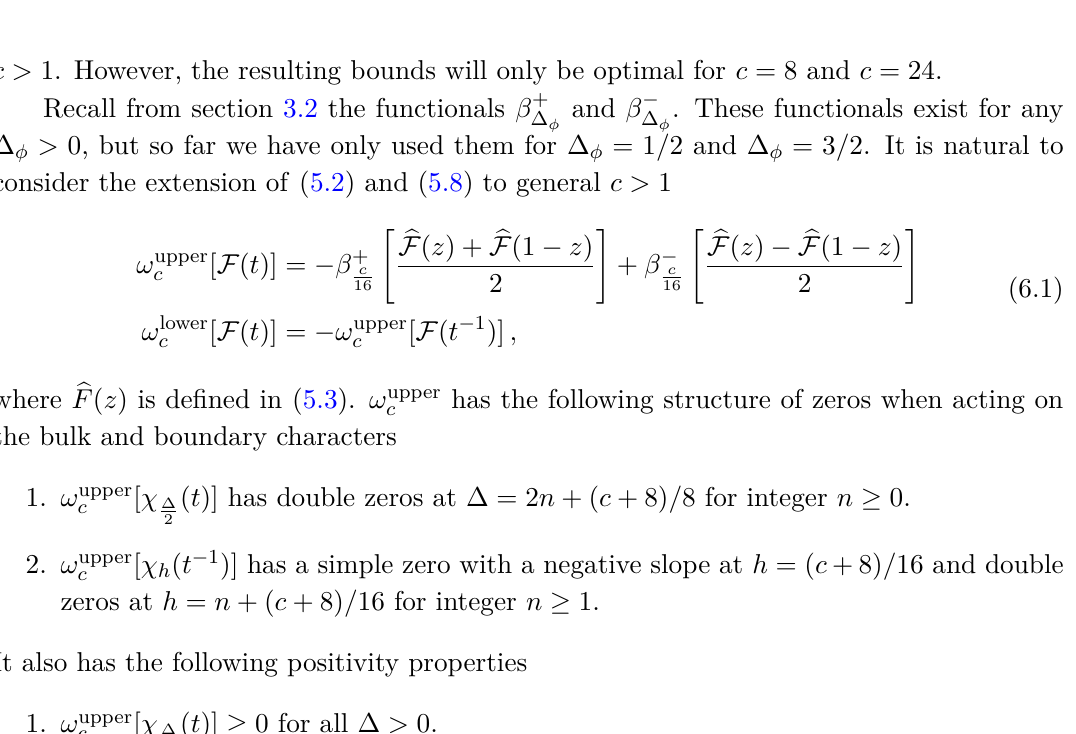
Figure 13. Bounds on the g function for 1 ≤ c ≤ 8 . The lower bounds (black) are computed assuming a gap in the spectrum of bulk scalars of ∆ gap = c gap for the range of central charges displayed. They are superposed with the upper bounds (red) computed assuming stability of the corresponding boundary